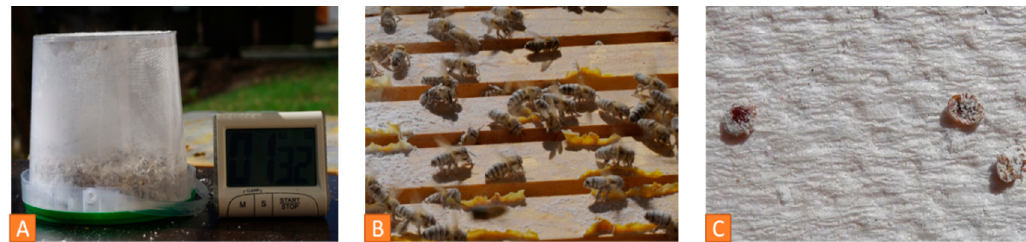
Figure 10. Varroa infestation control via iced sugar shaking method, ( A ) iced sugar-dusted bees in a shaking bucket, ( B ) dusted bees back in the hive after the procedure, ( C ) dusted mites on a paper towel. © Ilka Emmerich.